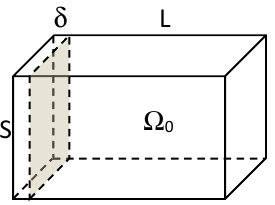
Fig. 1. Quasi-static movement of the left-hand side of an ether